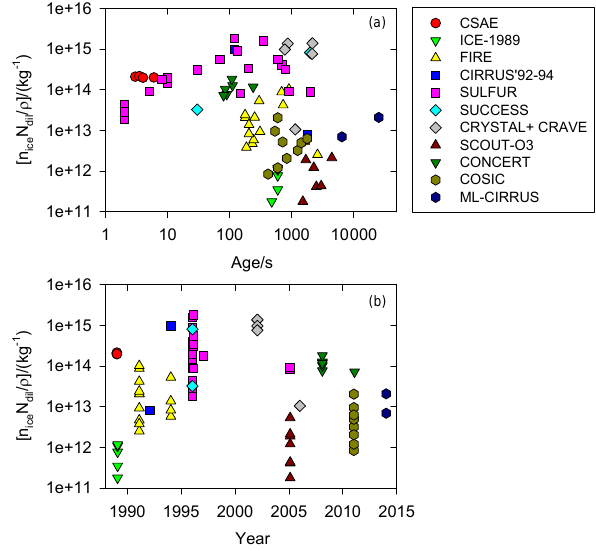
Figure 8. Particle concentrations n ice normalized to density and an empirical dilution law, approximating an apparent particle emission index, PEI ice (the number of ice particles in the contrail per burnt fuel mass). (b) Same quantity versus year of